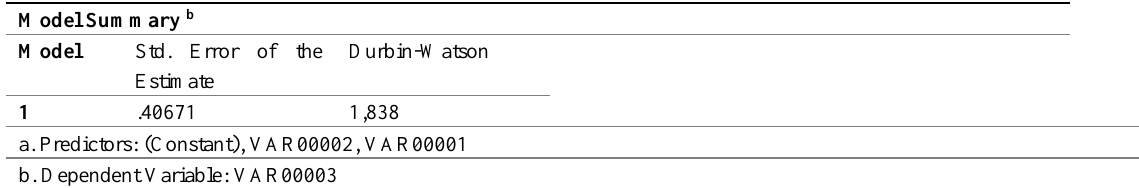
Table 6: Autocorrelation Test Results